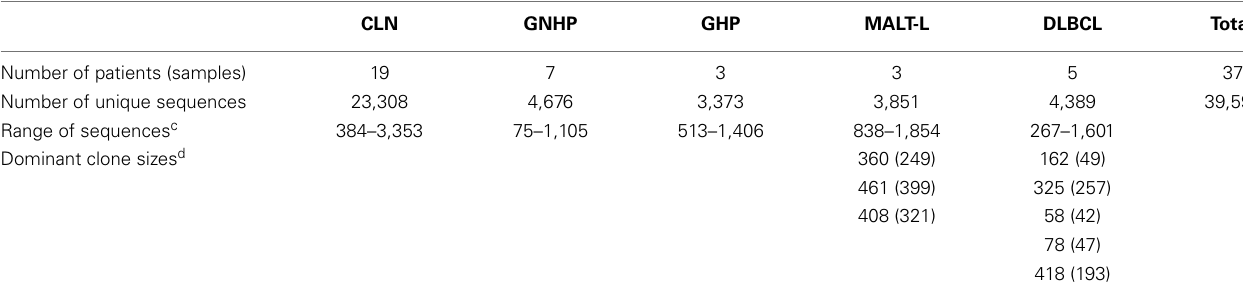
Table 4 | Number of unique sequences a , without suspected indels b , from each condition